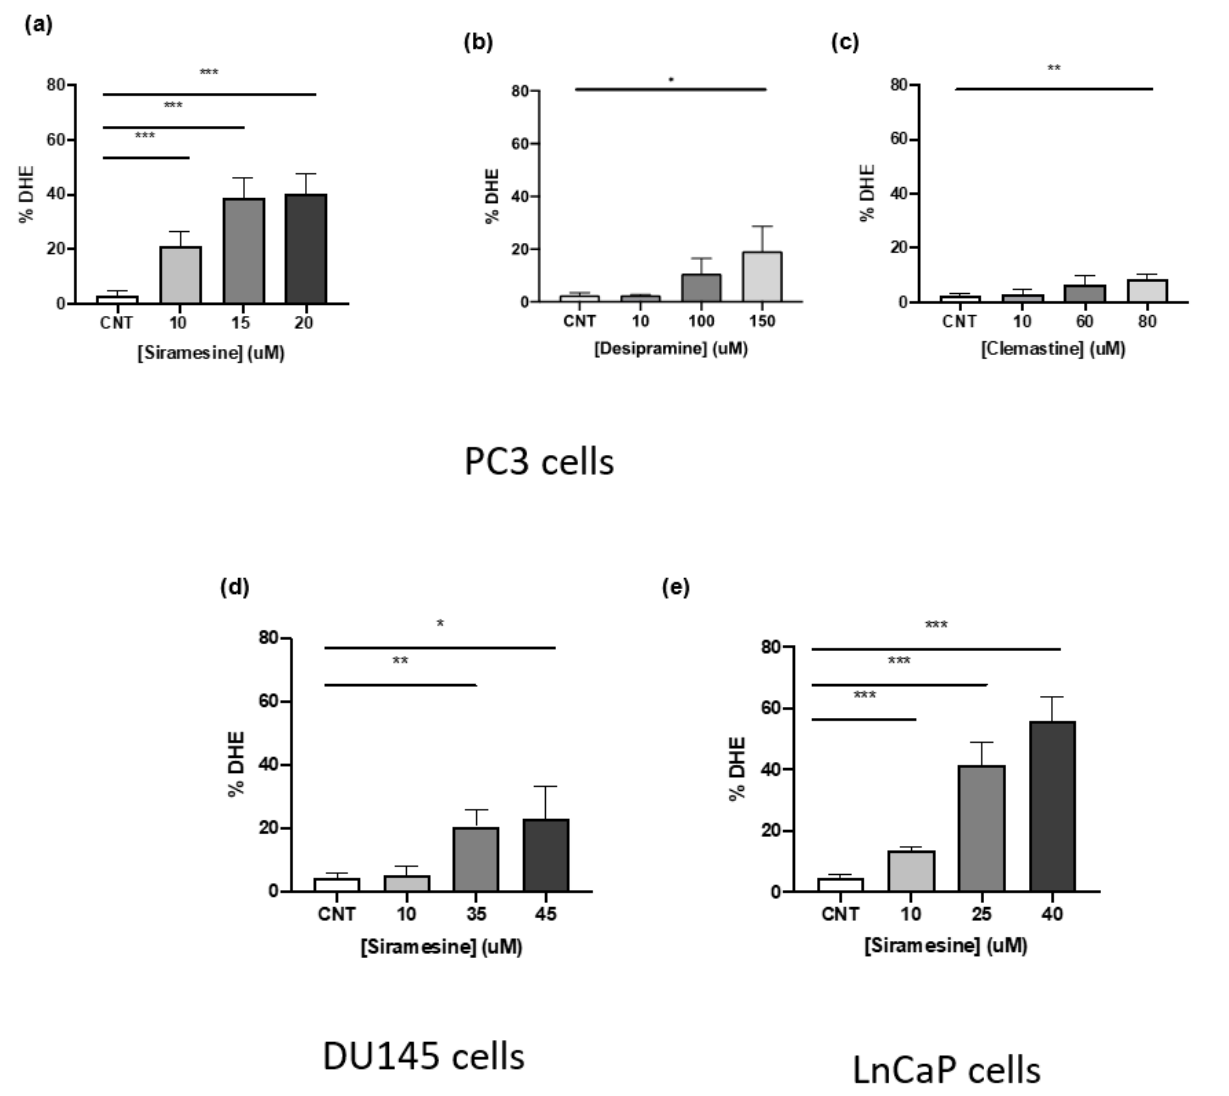
Figure 2. Siramesine, desipramine and clemastine induce ROS production after 4 h treatment. PC3 cells were treated with ( a ) siramesine, ( b ) desipramine, ( c ) and clemastine for 4 h, stained with the fluorescent dye dihydroethidium (DHE, 50 nM), and analyzed by flow cytometry. An increase in fluorescence indicates an increase in ROS levels. Results are representative of at least three independent replicates ( n = 3). ( d ) DU145, and ( e ) LNCaP cells were treated with increasing doses of siramesine for 4 h, stained with the fluorescent dye dihydroethidium (DHE, 50 nM) and analyzed by flow cytometry. An increase in fluorescence indicates an increase in ROS levels. Results are representative of at least three independent replicates ( n = 3). A p -value < 0.05 was considered statistically significant (represented by *) in addition to a p -value < 0.01 (represented by **), and a p -value < 0.001 (represented by